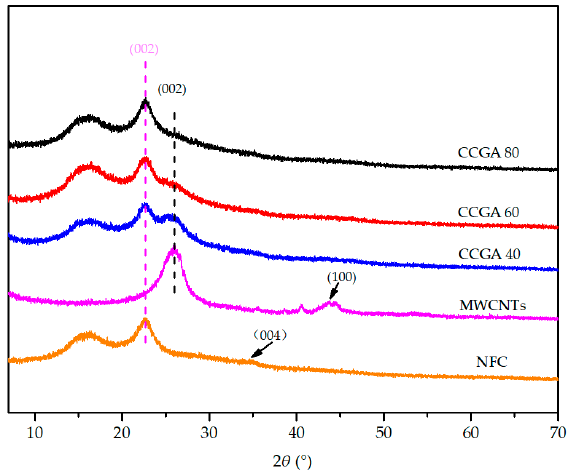
Figure 5. SEM image on upper surface of the aerogel ( a ) pure NFC, ( b ) CCGA 40, ( c ) CCGA 60, ( d ) CCGA 80 and SEM analysis at cross-section of the aerogel ( e ) pure NFC, ( f ) CCGA 40, ( g ) CCGA 60, ( h ) CCGA 80.